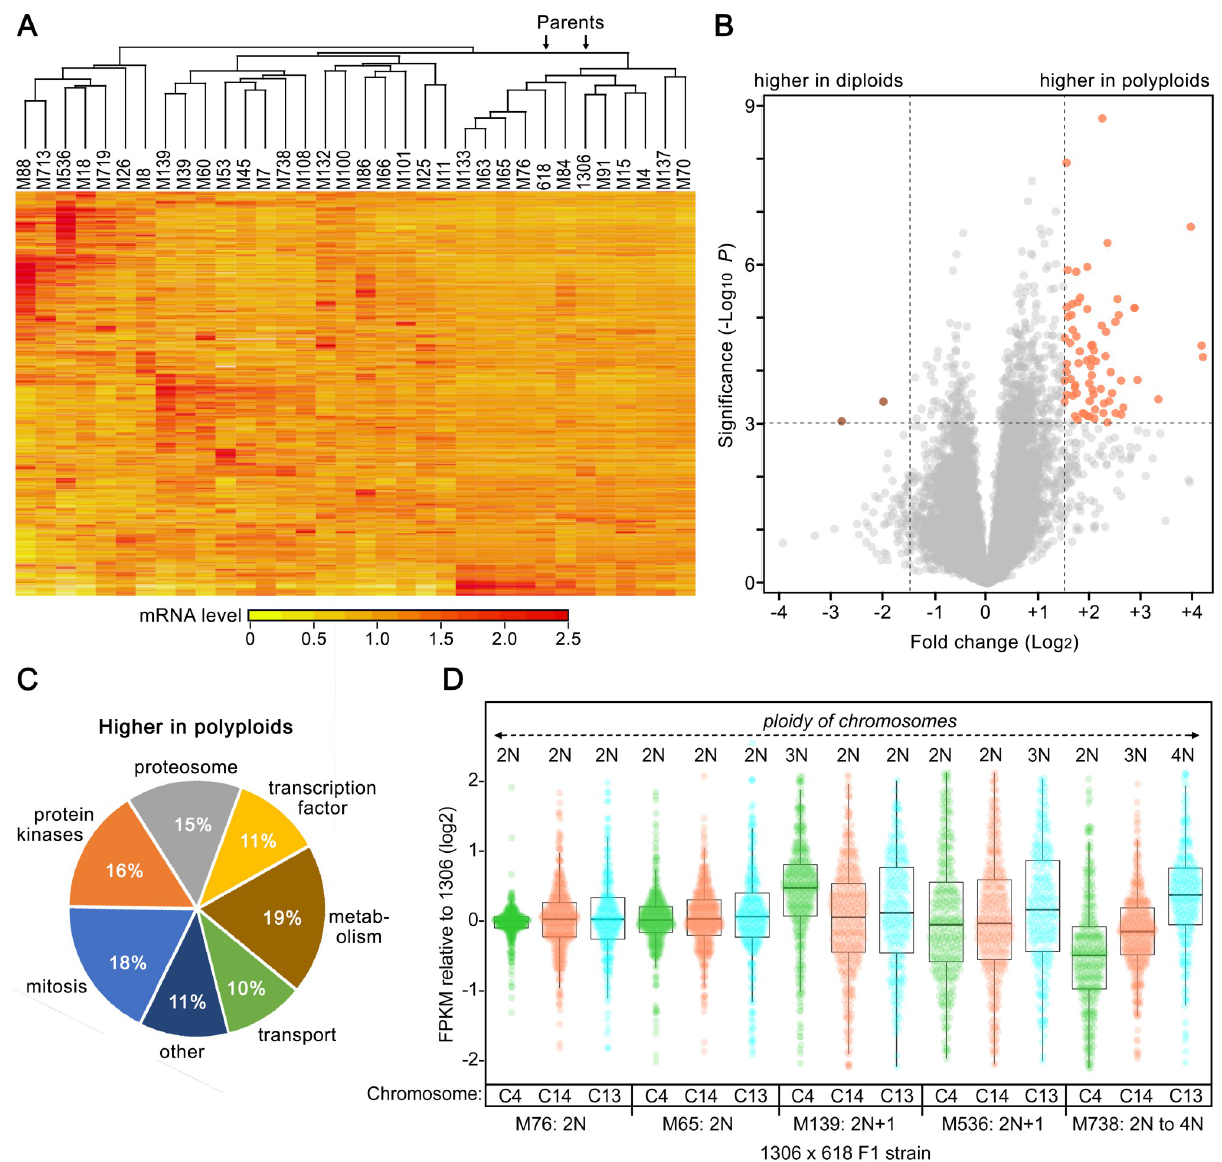
Fig 7. Diversity of transcriptome profiles in strains 1306, 618, and their progeny. A , Heatmap of RNA-seq data from mycelia, subjected to hierarchical clustering on both axes. Values are based on two samples per strain and are per-gene normalized to a mean of 1.0. The two parents are marked by arrows. B , Volcano plot comparing mRNA levels in mycelia of diploid and polyploid F1 strains. C , Functional classification of genes upregulated in polyploids. More details are provided in S3 and S4 Tables. D , Effect of chromosome dosage on gene expression. Indicated are FPKM ratios, compared to the diploid 1306, of genes on Chr4, Chr14, and Chr13 (C4, C14, and C13, respectively). Values are shown for diploid F1 strains M76 and M65, 2N+1 aneuploids M139 and M536, and F1 M738 in which chromosome numbers vary from 2N to